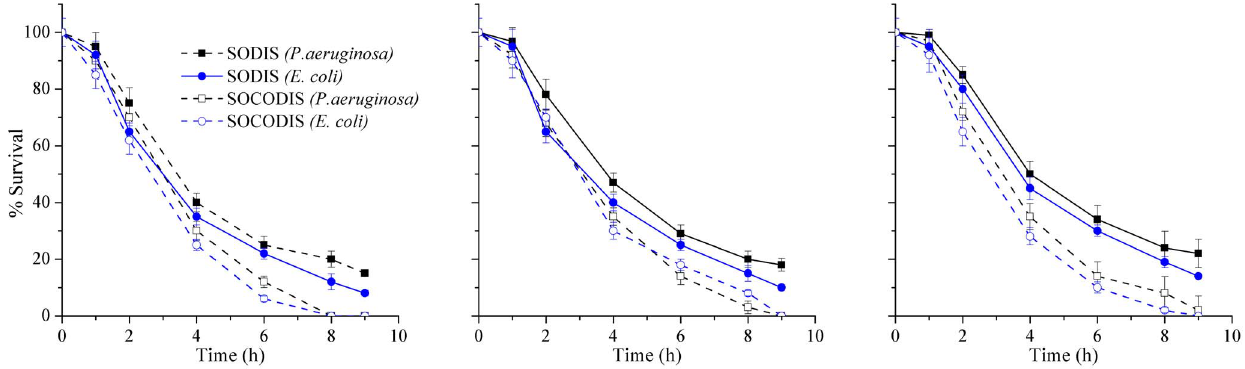
Figure 7. Effects on P.aeruginosa inactivation in both SODIS and SOCODIS system at mild weather at (a) low, (b) medium, and (c) high concentrations of E.coli.